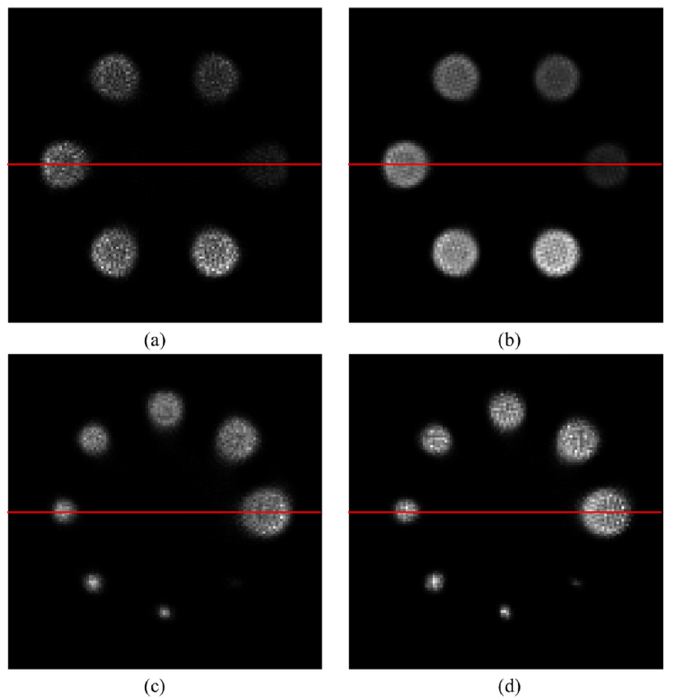
Figure 10. Profiles (red lines) and XFCT images of phantoms in Monte Carlo simulation. ( a , c ) reconstructed by MLEM without absorption correction, ( b , d ) reconstructed by MLEM with absorption correction.